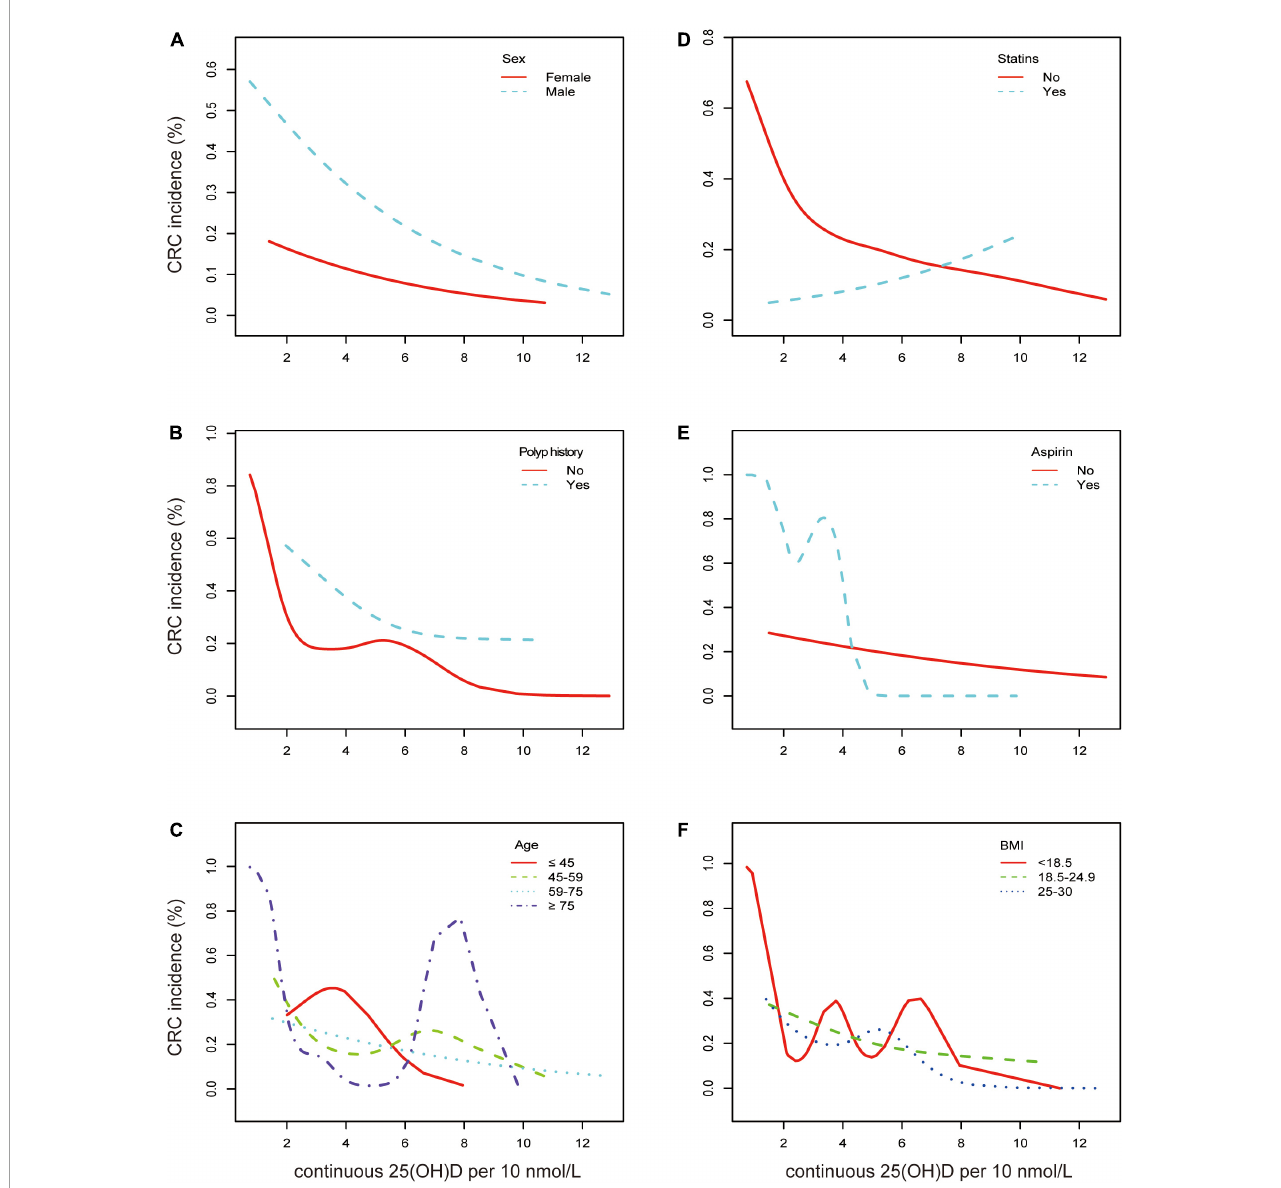
FIGURE3 Association between continuous 25(OH)D per 10 nmol/L and CRC according to baseline characteristics. Smooth fitting curve adjusted for sex, age, polyps history, diabetes, hypertension, smoking, alcohol, aspirin, statins, ACEI, VA, VB1, VB6, VB9, VB12, VC, VE, VD, and BMI. (A) Aqua dashed line represents the spline plots of men and the red solid line represents those of women. (B) Aqua dashed line represents the spline plots of polyp history and red solid line represents participants without polyp. (C) Red solid line represents the spline plots of age < 45 years, green dashed line represents age between 45 and 59 years, aqua dotted line represents age between 60 and 75 years, and the purple dash-dotted line represents age ≥ 75 years. (D) Aqua dashed line represents the spline plots of statin treatment and red solid line represents participants without statin treatment. (E) Aqua dashed line represents the spline plots of aspirin use and red solid line represents participants without aspirin. (F) Red solid line represents the spline plots of BMI < 18.5, green dashed line represents BMI between 18.5 and 24.9, and blue dotted line represents BMI between 25 and